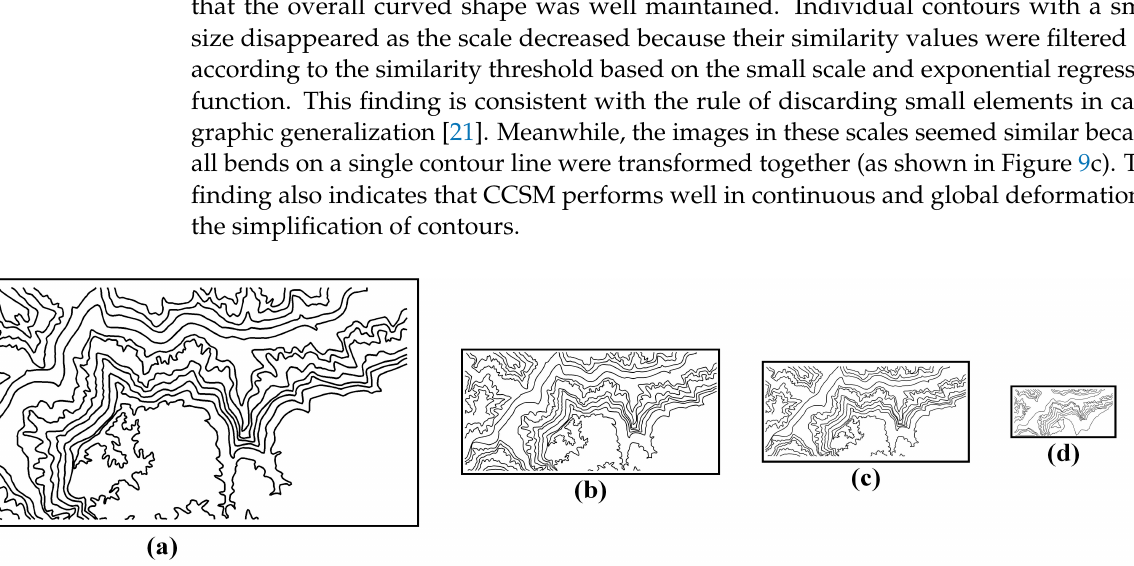
Figure 19. Terrain features in the terrain map of 1:50,000. As shown in Figure 20, with the progressive simplification of the contour line, some details of the contour lines were continuously reduced, and some ridge and valley lines gradually disappeared. The simplified terrain map only retained some key ridge and valley lines. However, the topological relationship of all simplified contours was also consistent, thereby suggesting that the key corresponding geographical features were maintained. Therefore, CCSM also performs well in maintaining the terrain features of geographical contours with complex linear features. Figure 20 also shows that even though CCSM is used for single line simplification, this method can also well maintain the group multi-scale continuous rendering of simplified contour lines.